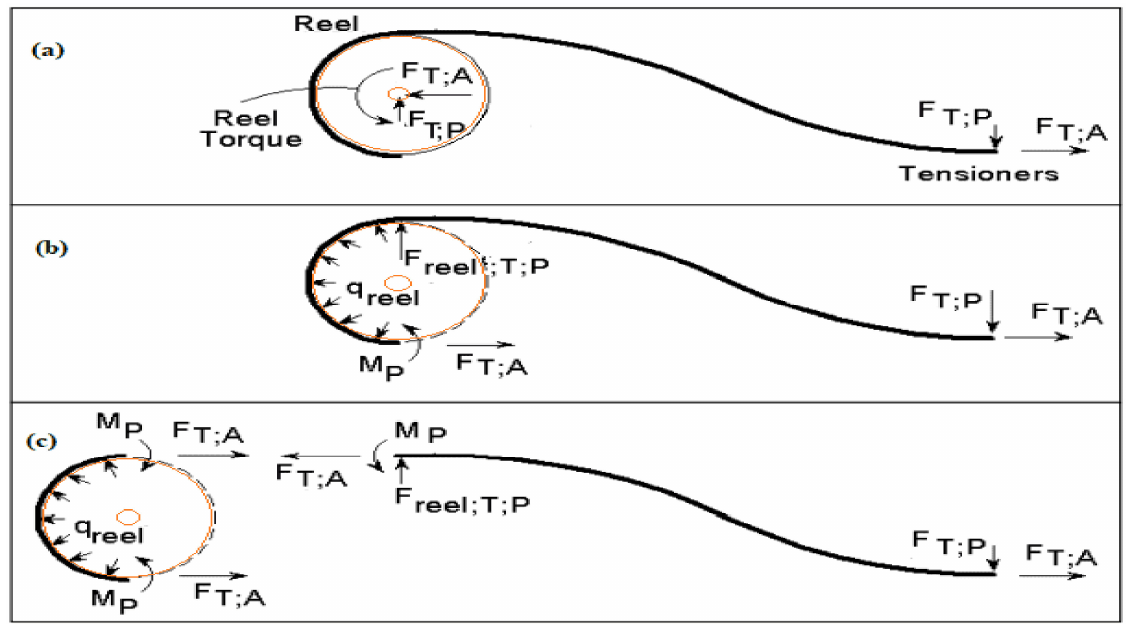
Figure 7. Forces on the ( a ) hoseline and the reel during spooling-on in reality, ( b ) hoseline during spooling-on in reality and ( c ) mechanical system for hose and reel separately for